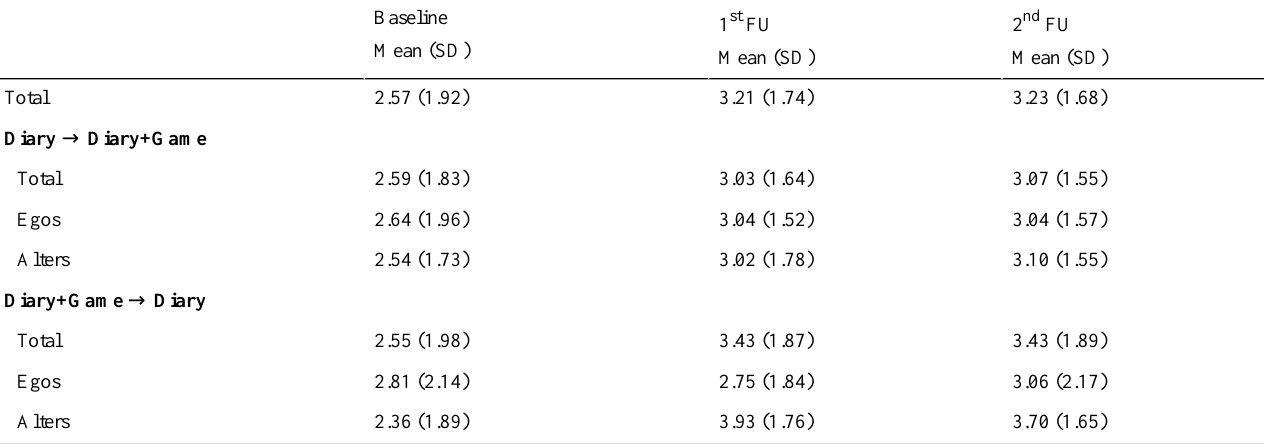
Table 2. Self-reported days per week exercised by study condition and participant status.